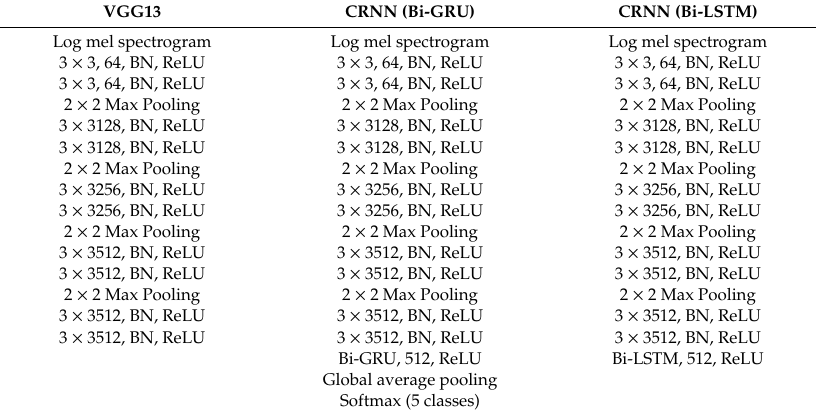
Table 3. Various learning models used for the input source. The basic structure of all learning models comprises a neuron model called VGG13. First, the input data (Log Mel spectrogram) to VGG13 is convolved with 64 filters of 3 × 3 size, and the same convolution is repeated. Next, a rectified linear unit (ReLU) is used as the activation function, and Batch normalization (BN) is performed on the obtained data. Subsequently, the information is compressed using a 2 × 2 size filter called max pooling. Then, the same operation is repeated by gradually increasing the number of filters so that fine features can be captured e ff ectively. Finally, all the obtained data are combined, the activation function (softmax) is used to stimulate 5 neurons, and the output value represents classification into 5 classes. When using convolutional recurrent neural network (CRNN), we use data convoluted by VGG13 as the input data before fully combining them. The output results using the bidirectional gated recurrent units (Bi-GRU) or bidirectional long short-term memory (Bi-LSTM) of the neuron model, which can evaluate the time axis, are connected to the fully connected layer and classified into five